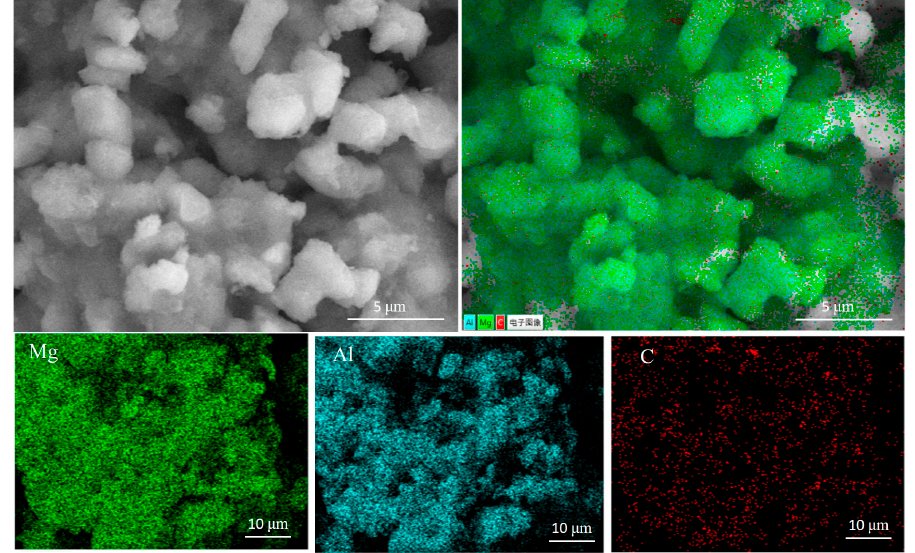
Figure 6. SEM tests on the multilayer graphene-decorated Al 3 Mg 2 alloy.